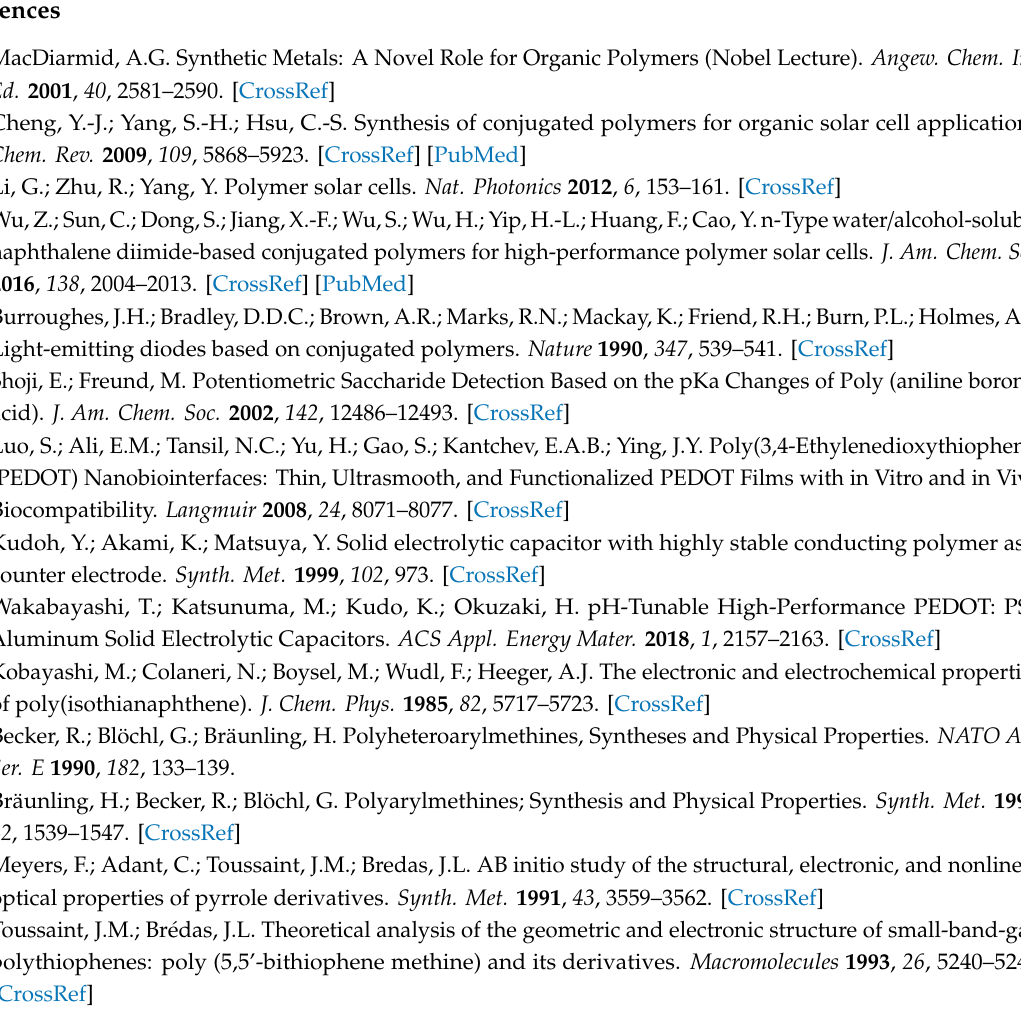
Figure S1: 1 H-NMR spectrum of P1 in DMSO-d 6 ; Figure S2: 1 H-NMR spectrum of Pyr(non) in DMSO-d 6 ; Figure S3: UV-Vis-NIR spectra of polymers ( P2 - P5 ) dissolved in phosphate bu ff er, [polymer] = 4.0 g / L, cell length: 0.1 mm; Figure S4: (hv α ) 2 versus photon energy around the absorption edge of polymers (P4 , P5 ) dissolved in phosphate bu ff er, [polymer] = 4.0 g / L, cell length: 0.1 mm; Figure S5: Di ff use reflection spectra of the powdered polymers; Figure S6: TGA curves of P4-6 with a heating rate of 5 ◦ C / min in